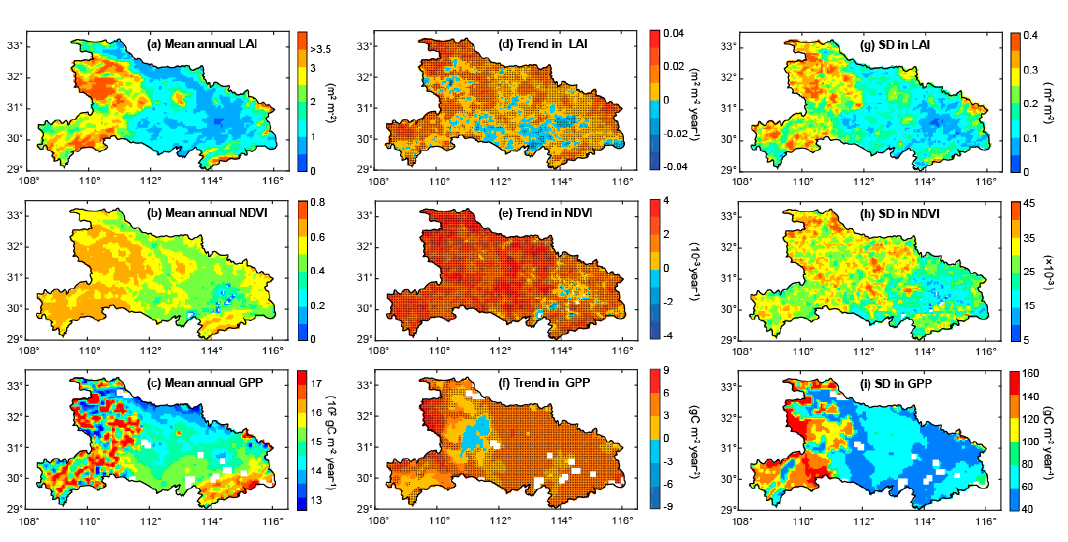
Figure 3. Spatial distribution of mean values ( a – c ), trends ( d – f ) and SDs ( g – i ) for LAI, NDVI, and GPP during 1982–2015. Black points indicate pixels where the trends are significant at the 0.05 significance level in panels ( d – f ).